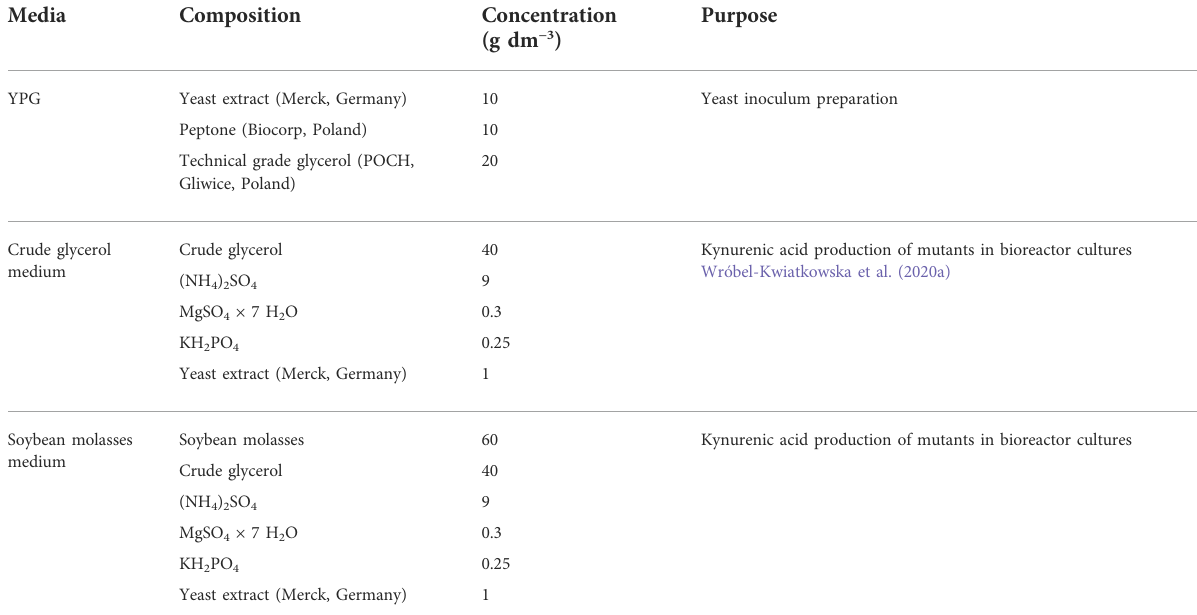
TABLE 3 Composition of media used in this